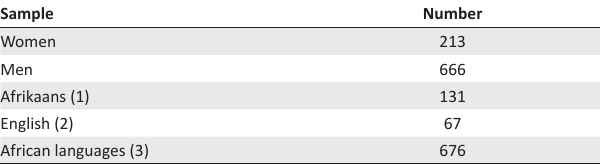
TABLE 1: Sample characteristics for English Comprehension Test 1.3.